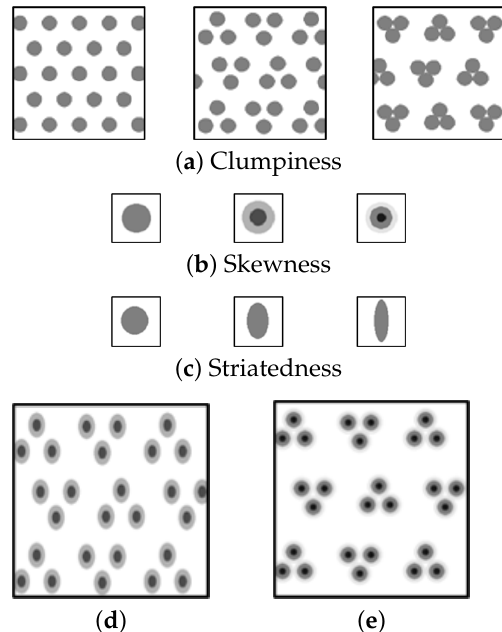
Figure 6. Textures; low, mid, and high level (from left to right) ; other metrics are similar except for the displayed metric in the left label; ( a – c ) sample textures for conveying Scagnostics metrics. ( d , e ) two synthesized textures—mid clumpy, skew and striated ( d ), high clumpy and skew, and low striated ( e ). Table 1. Results from user study 1. Entries are read as RIGHT/TOTAL (% Correct).